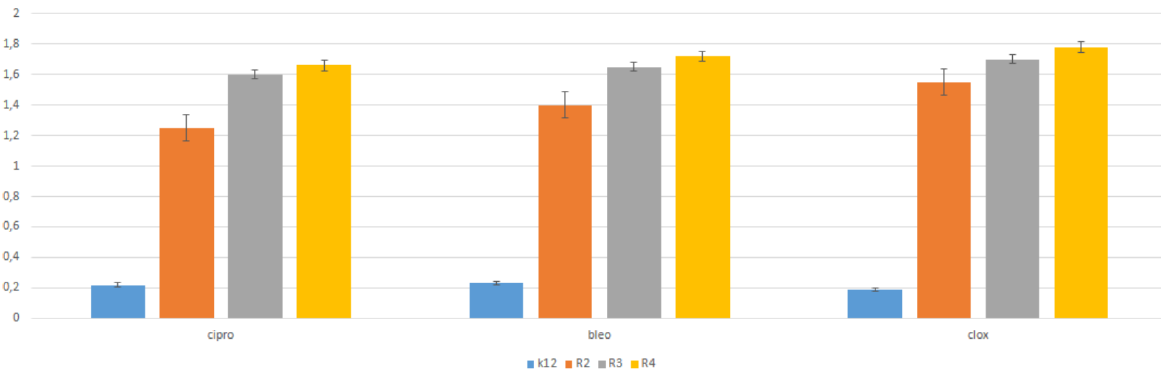
Figure 7. Examples of MIC with model bacterial strains K12, R2, R3, and R4 for studying antibiotics ciprofloxacin, bleomycin, and mechanism. The x -axis features antibiotics used sequentially. The y -axis features the MIC value in µ g/mL − 1 . Each experiment was performed independently in 3 replications ( n =